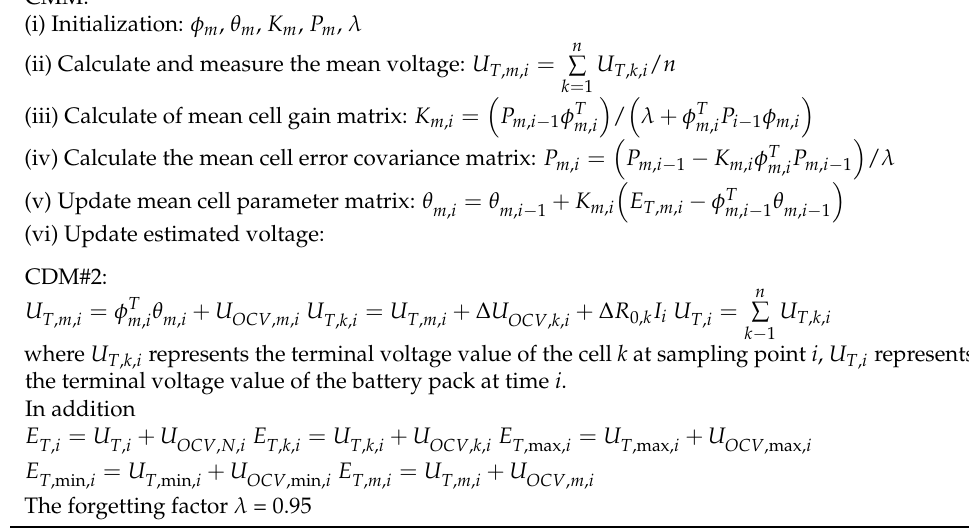
Table 2. M+D Model parameter identification.